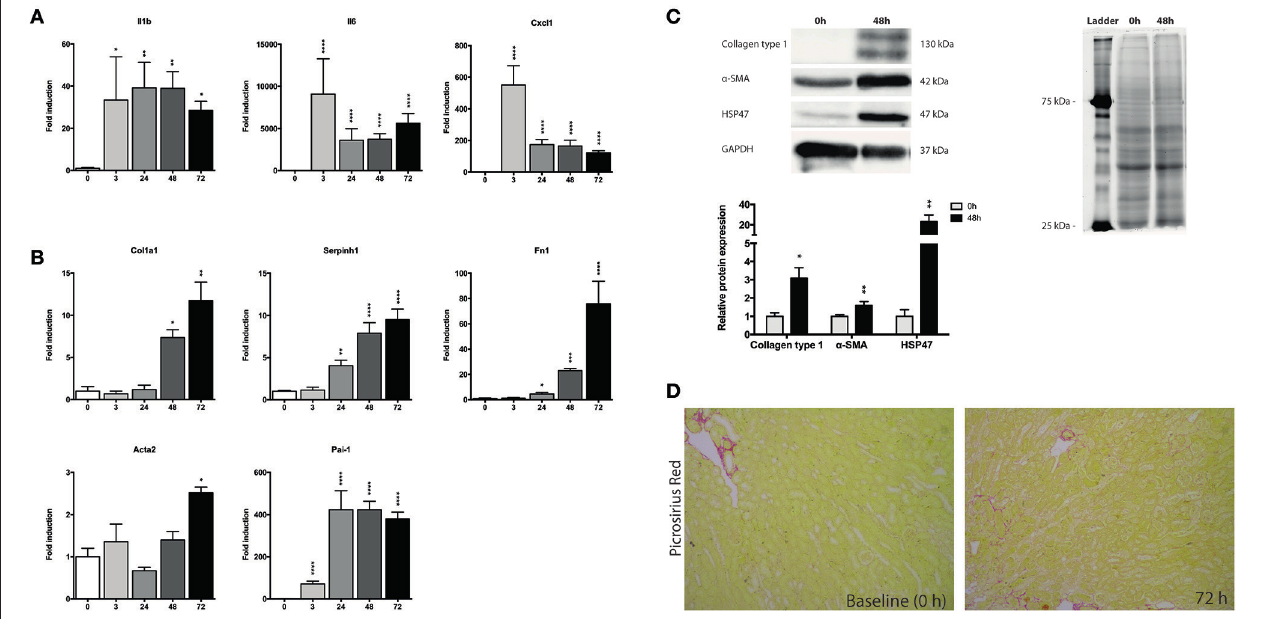
FIGURE 3 | Expression of fibrosis and inflammatory markers during incubation of mPCKS. (A) mRNA expression of inflammation markers. (B) mRNA expression of fibrosis markers. (C) Protein levels of collagen type 1, α -SMA, and HSP47 at baseline and 48h with representative Western blot images. (D) Picrosirius red staining of mPCKS visibly increased at 72h compared to baseline expression (0h). * p < 0.05, ** p < 0.001, *** p < 0.001, **** p < 0.0001. Data is expressed as mean ( ± SEM), n = 3–5. Il1b, interleukin 1 beta; Il6, interleukin 6; Cxcl1, C-X-C motif chemokine ligand 1; Col1a1, collagen type I alpha 1; Serpinh1, serine proteinase inhibitor clade H (Heat Shock Protein 47) member 1; Fn1, fibronectin 1; Acta2, alpha 2 smooth muscle actin; Pai-1, Plasminogen activator inhibitor-1; α -SMA (alpha smooth muscle actin); HSP47, heat-shock protein 47; kDa,